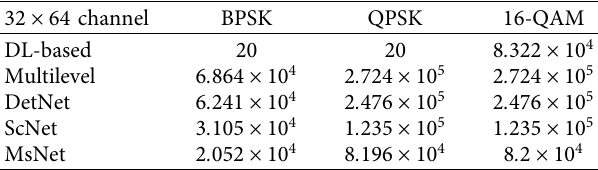
Table 3: Comparison of trainable